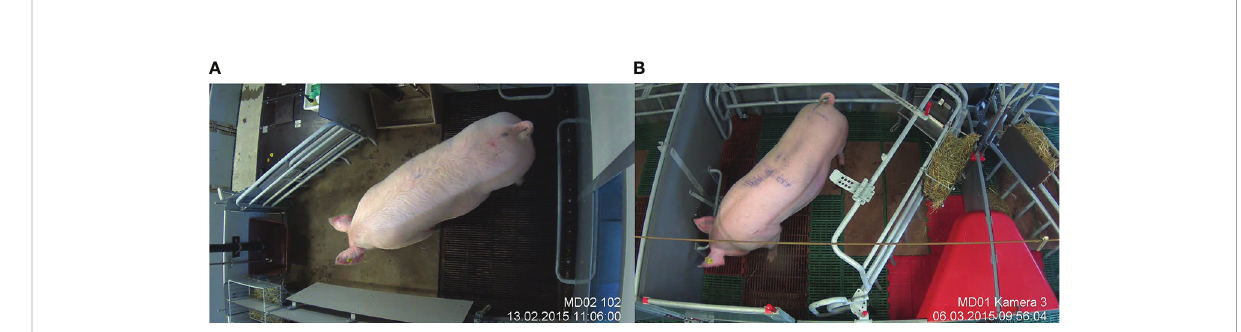
FIGURE 1 Farrowing pens with the possibility of temporary crating. (A) SWAP pen. (B) trapezoid